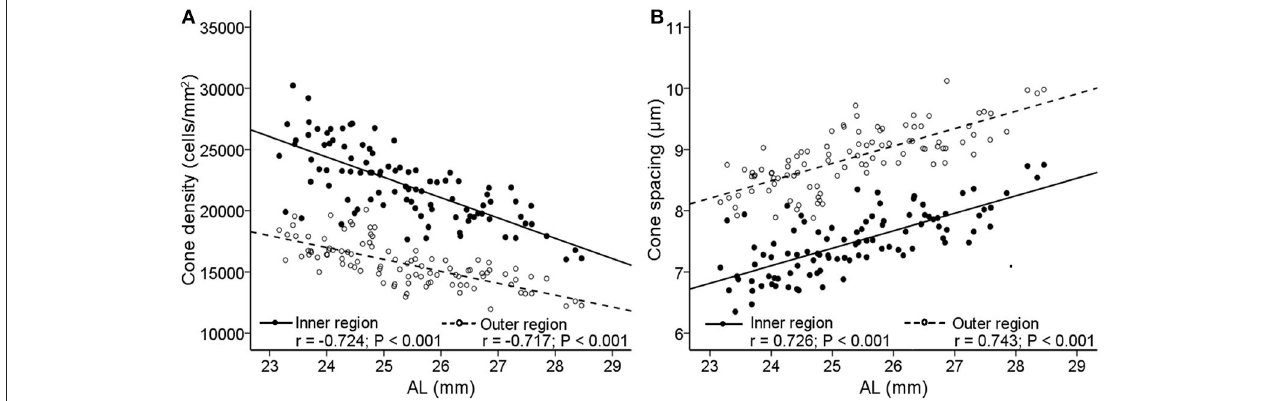
FIGURE 5 | Correlations between AL and cone photoreceptor spatial distribution features. Scatterplots show AL vs. (A) cone density; (B) cone spacing. The solid lines and filled circles represent the results in the inner region. The dashed lines and open circles represent the results in the outer region. AL, axial length.